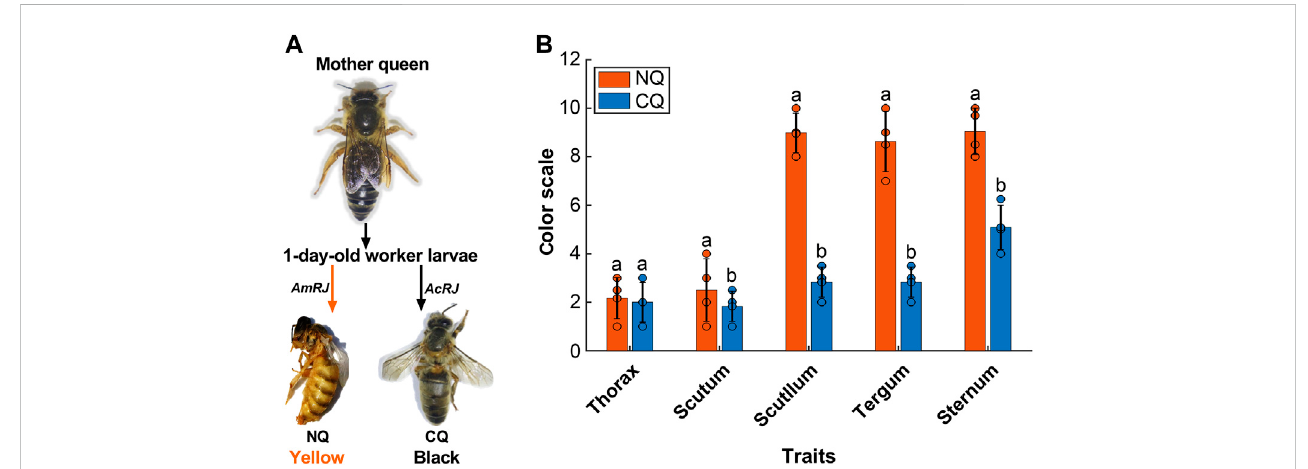
FIGURE 1 (A) The body color alternation in Apis cerana-Apis mellifera nutritional crossbreed. The 1-day worker larvae from their A. cerana mother queen were fed with A. mellifera royal jelly ( Am RJ) based diet or A. cerana royal jelly ( Ac RJ), resulted in yellow color nutritional crossbreed queens (NQ) or black color control queens (CQ) respectively. (B) The body color quanti fi cation had signi fi cant differences of (NQs, n = 4, Scutum ’ s M = 2.5, SD = 1.29, t = 0.85, Scutellum ’ s M = 8.9, SD = 0.81, t = 5.84, Tergum ’ s M = 8.5, SD = 1.25, t = 63.81, and Sternum ’ s M = 9.5, SD = 0.95, t = 15.4) compared to (CQs, n = 4, Scutum ’ s M = 1.83,